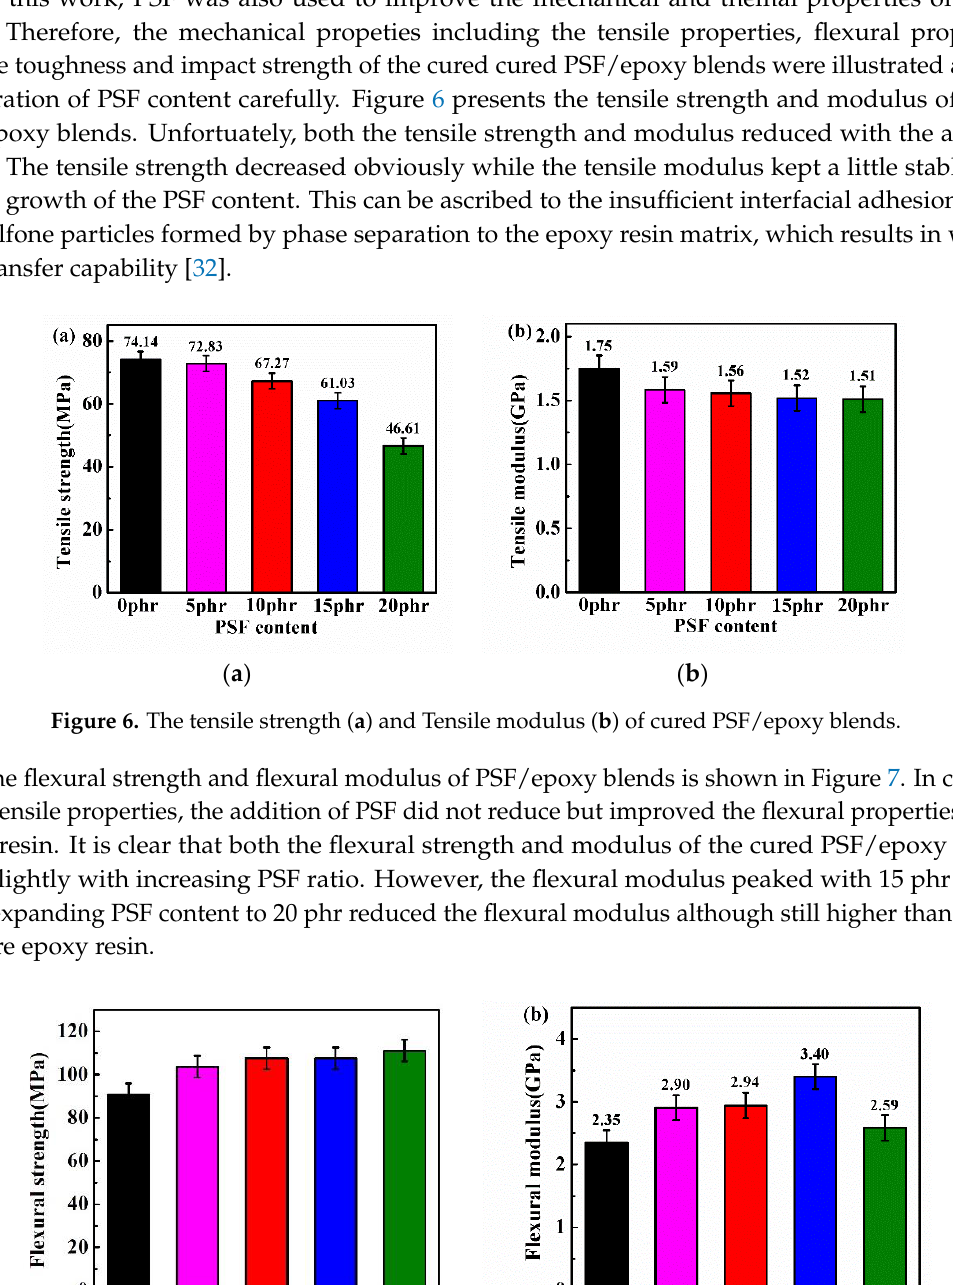
Figure 5. Curves of ( a ) storage modulus E’ and ( b ) tan δ with temperatures of PSF/epoxy cured products containing different PSF content.